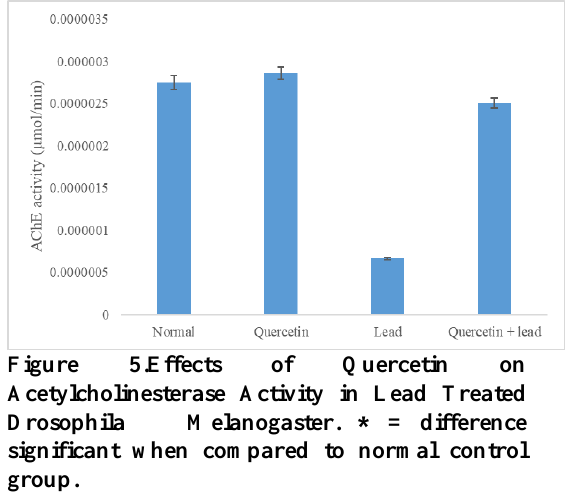
Figure of Quercetin on Acetylcholinesterase Activity in Lead Treated Drosophila Melanogaster. * = difference significant when compared to normal control